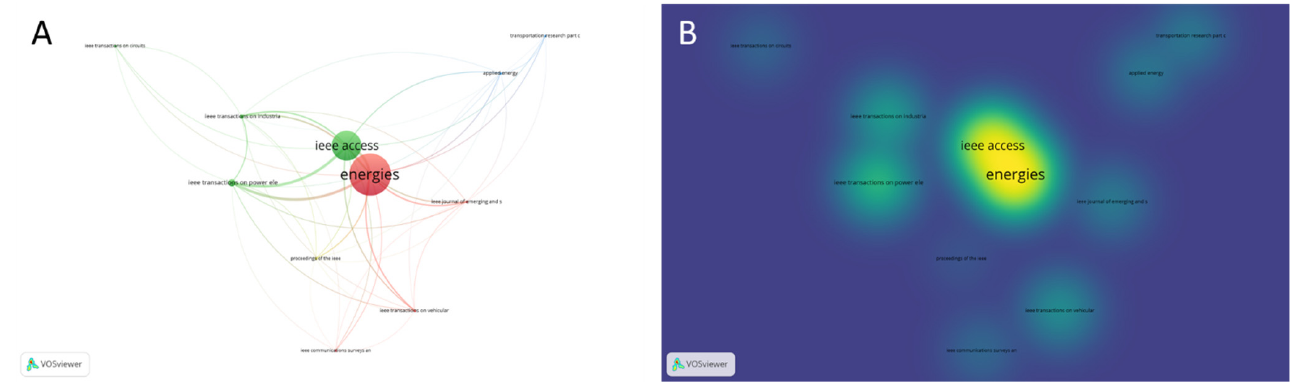
Figure 11. Citation Network for Sources. Network visualization ( A ) and density map ( B ) show 11 out of 289 sources that met the threshold of 1 document and 300 citations per source. There were four clusters and 44 links.